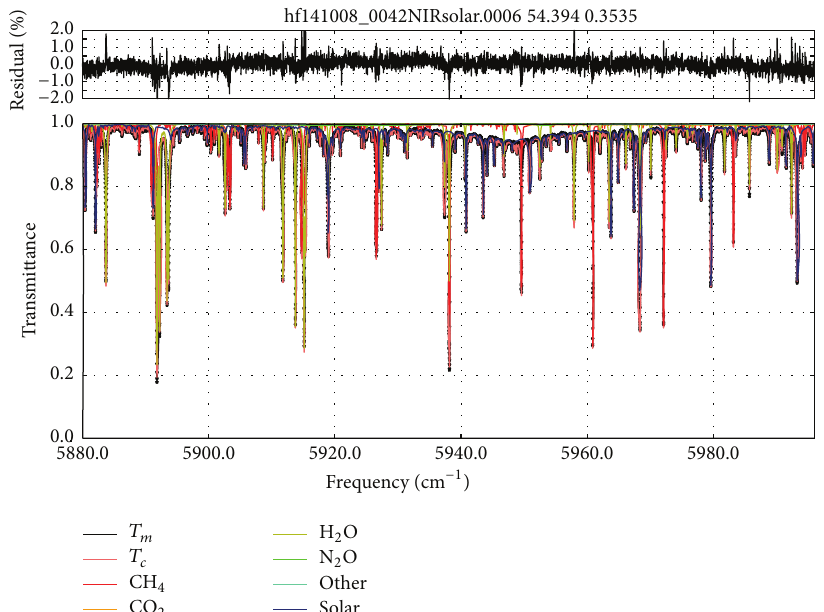
Figure 3: CH 4 spectral fitting within 5938 cm −1 window: the spectrum was recorded on October 8, 2014, 0:47 (UTC). Black lines are the measurements, orange lines are the fitted transmittance, and contributions from individual gases are shown in color. Fitting residuals ( 𝑇 𝑚 −𝑇 𝑐 ) for CH 4 are